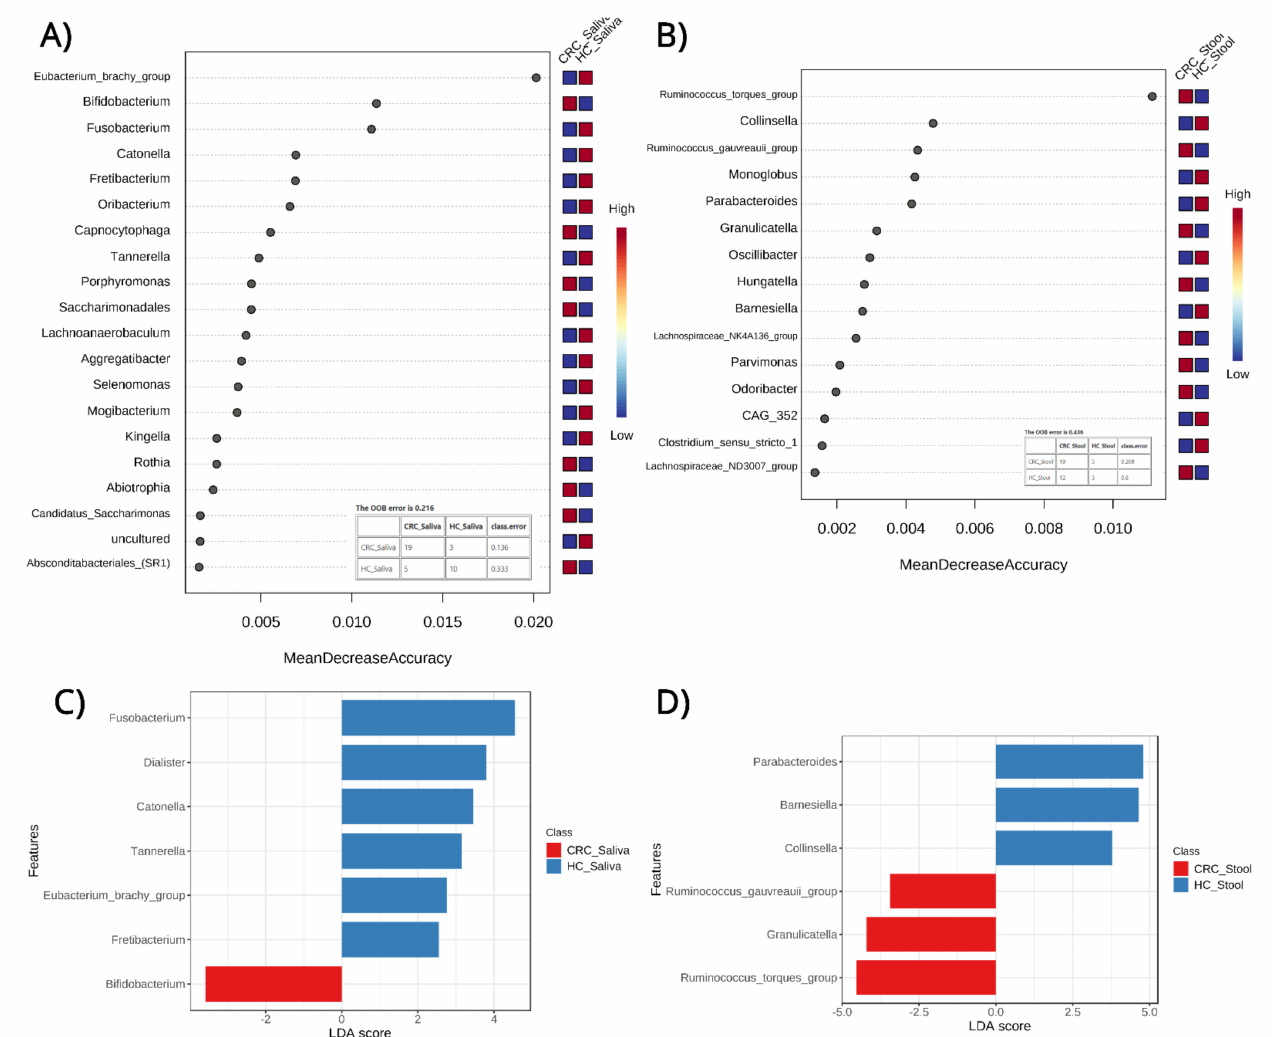
Figure 5. Top features (bacterial genera) in Random Forest (RF) models using ( A ) saliva samples of CRC (Colorectal cancer) patients and healthy controls (HC); ( B ) stool samples of CRC patients and healthy controls to predict sample classification into the patient and control groups. Figures also include Out-Of-Bag error and classification matrices for each model. In addition, Linear Discriminant Analysis (LDA) ( C , D ) between the same sample groups reveals bacterial genera which can serve as biomarkers for possible sample classification in CRC. Both approaches highlight, through different statistical methodologies, specific bacterial genera. •